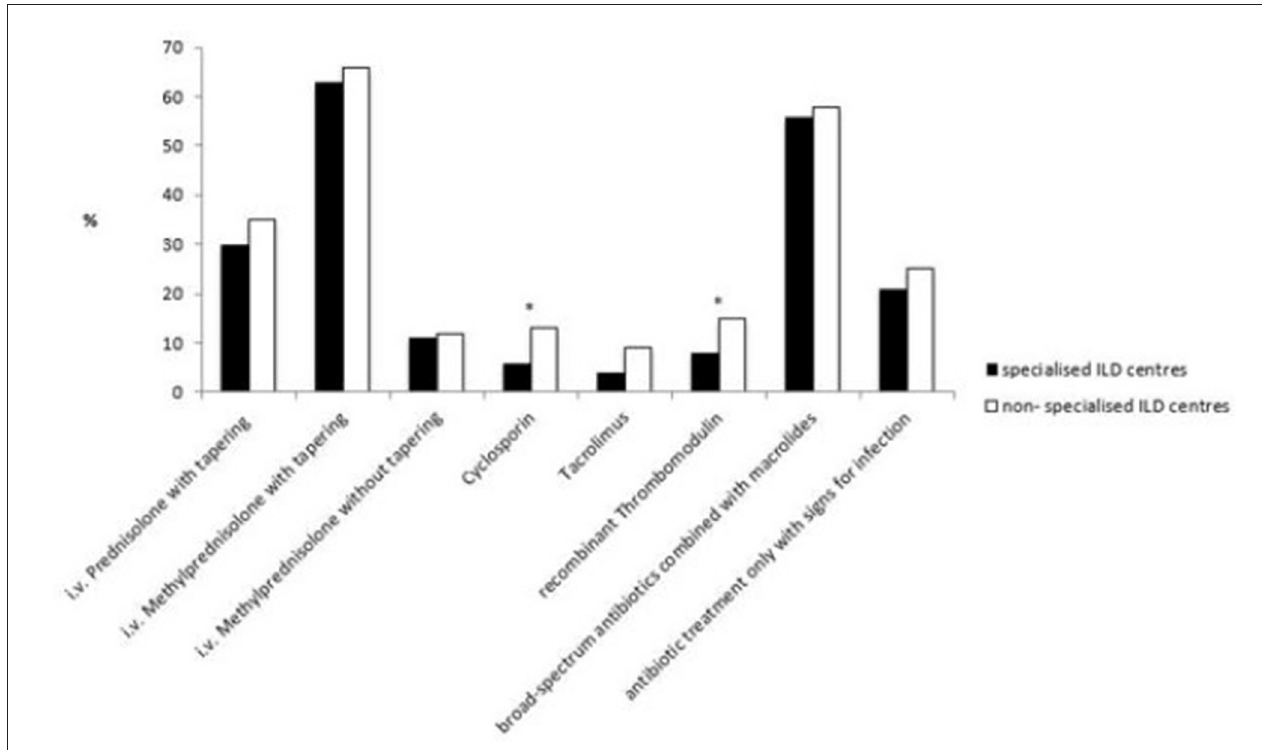
FIGURE 3 | Different treatment strategies towards AE-IPF in specialised and non-specialised ILD centres. Statistically significant differences are labelled with a * (p-value = < 0.05).